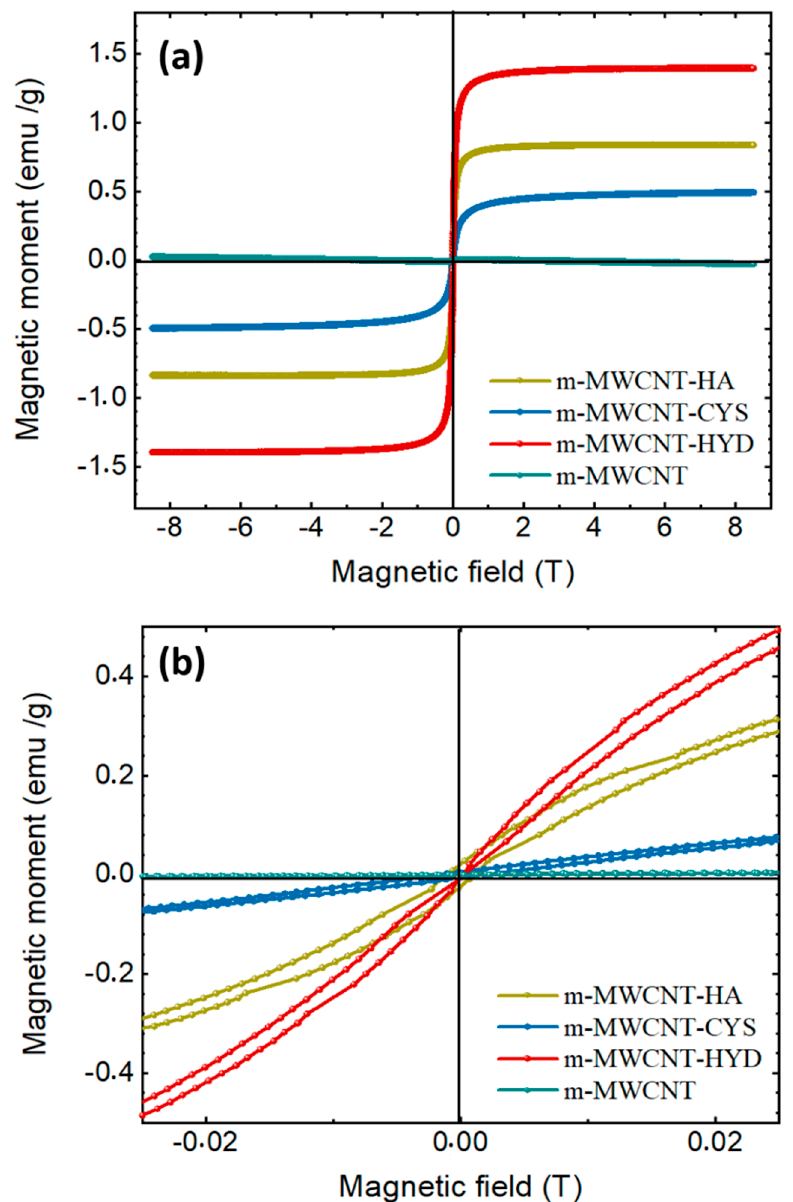
Figure 7. Magnetic field dependence of the magnetization measured at ( a ) 300 K (M–H loops) of m-MWCNT–HA, m-MWCNT–CYS, m-MWCNT–HYD and MWCNT; ( b ) the magnification of the central area of the hysteresis loops.